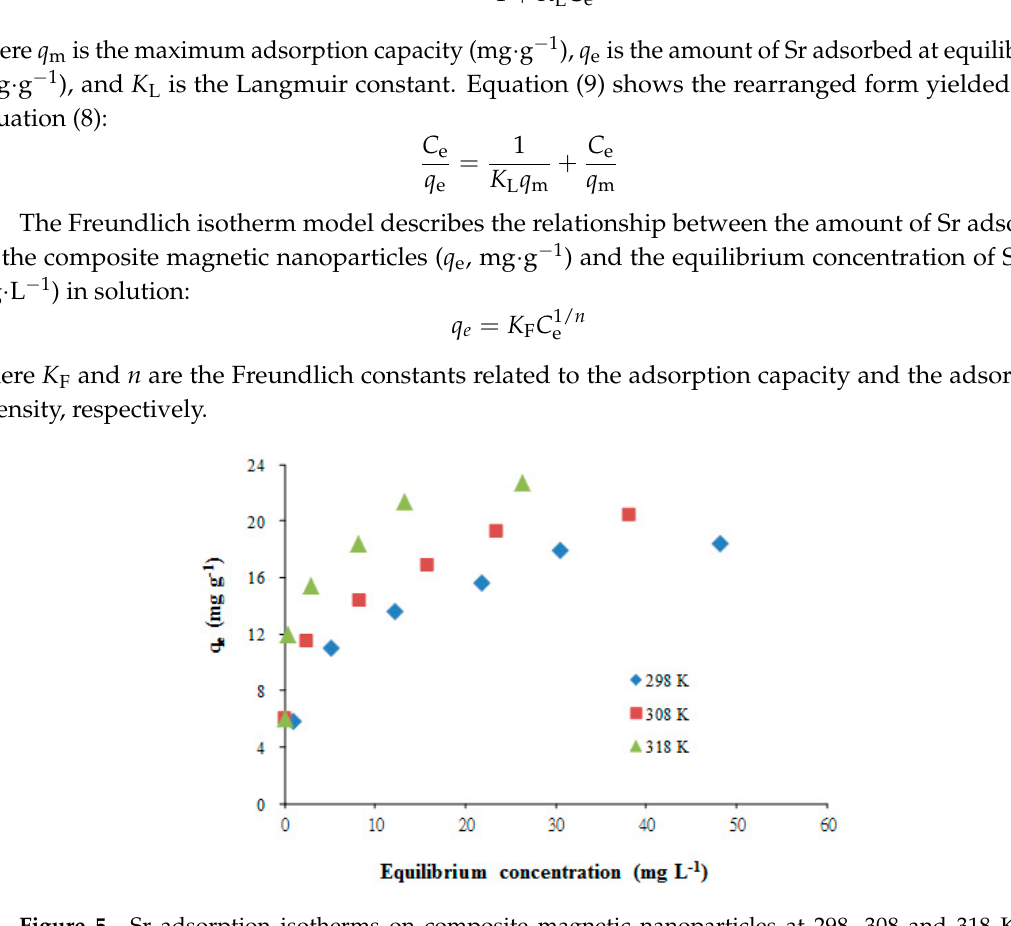
Figure 5. Sr adsorption isotherms on composite magnetic nanoparticles at 298, 308 and 318 K. Conditions: Adsorbent dose 5 g ∙ L − 1 , pH 10.25.